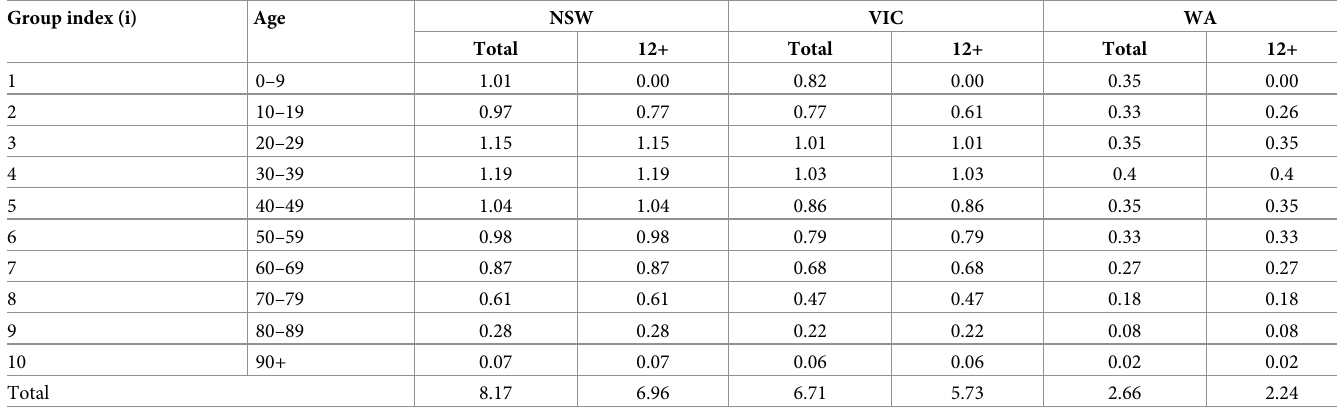
Table 1. Australian, NSW, VIC, and WA age cohorts (millions of